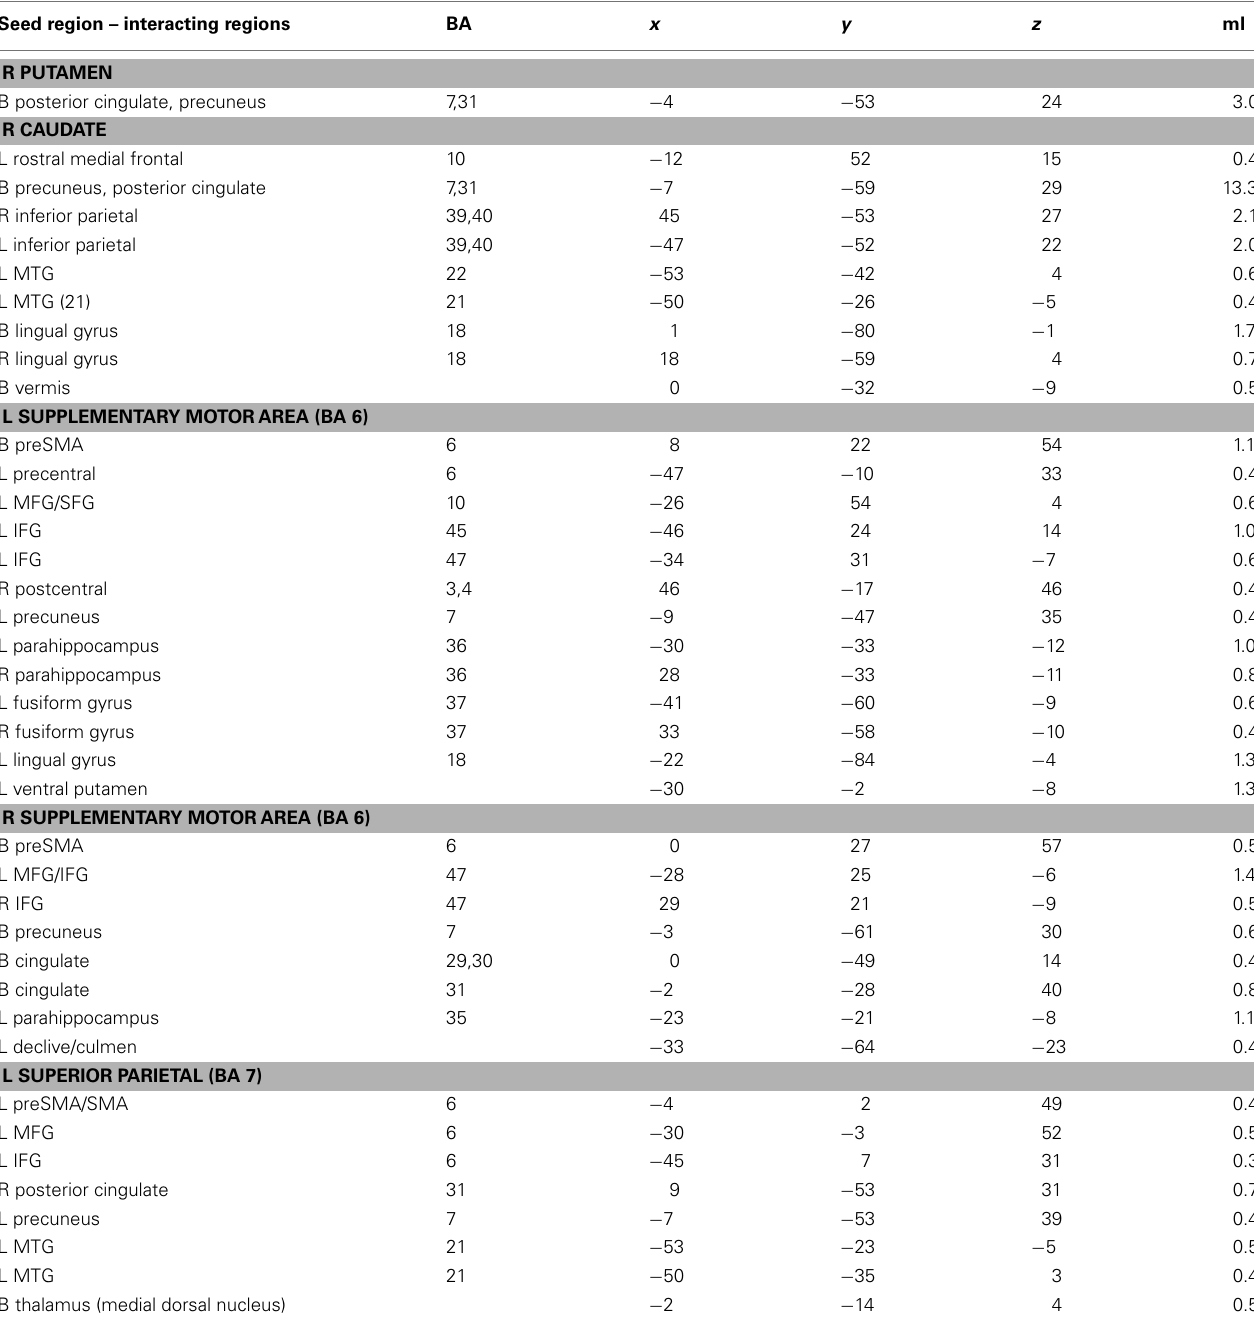
Table 2 | Regions showing effective connectivity with the striatum and cortical ROI that was modulated by the timing condition (unimodal versus